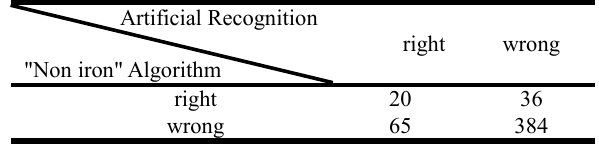
Table 3. Confusion matrix of wrong extracted